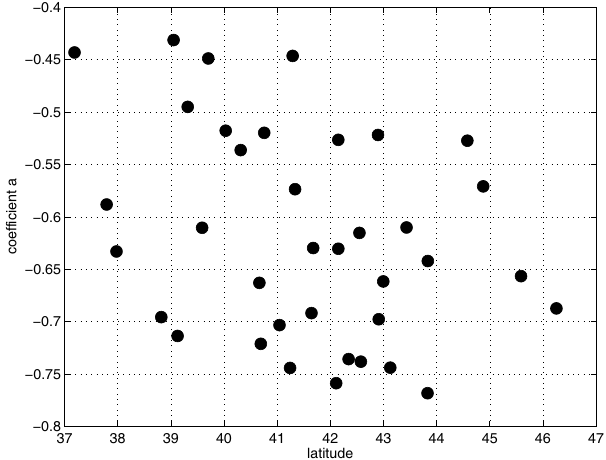
Figure 5. Weights of the CD parameters of the SPEI-BA model (i.e. the coefficients a(i) of Eq. 1) plotted against the latitude of the centroids of the